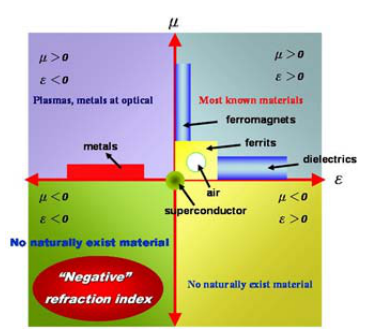
Figure 1: Materials